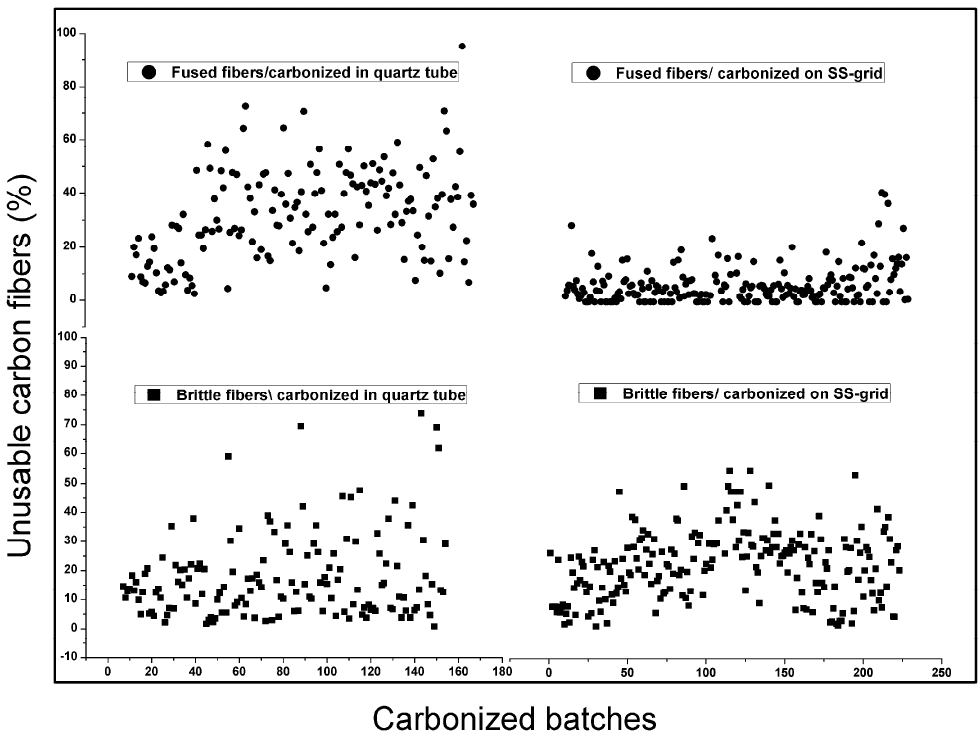
Figure 8. Fused and brittle fibers after carbonization, results with quartz tube ( left ), and results with SS-grid ( right ).